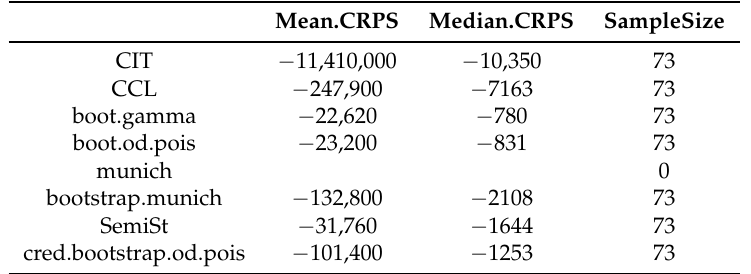
Table 11. Average and median CRPS values from the private passenger auto liability